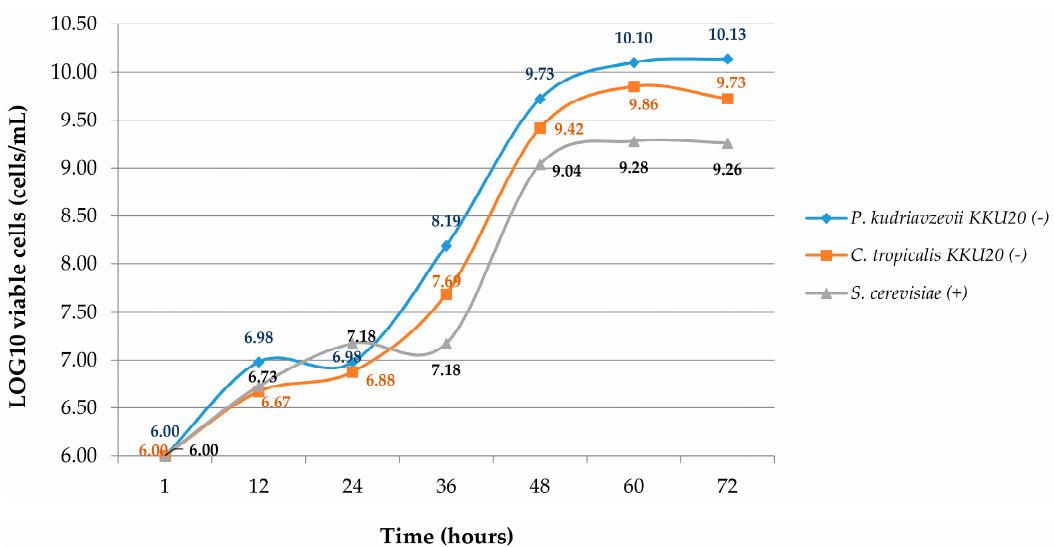
Figure 1. Cell growth pattern of three selected yeasts strains (Crabtree-positive and -negative yeasts) expressed under aerobic condition in molasses 250 g/kg with urea 10 g/kg by viable direct count.